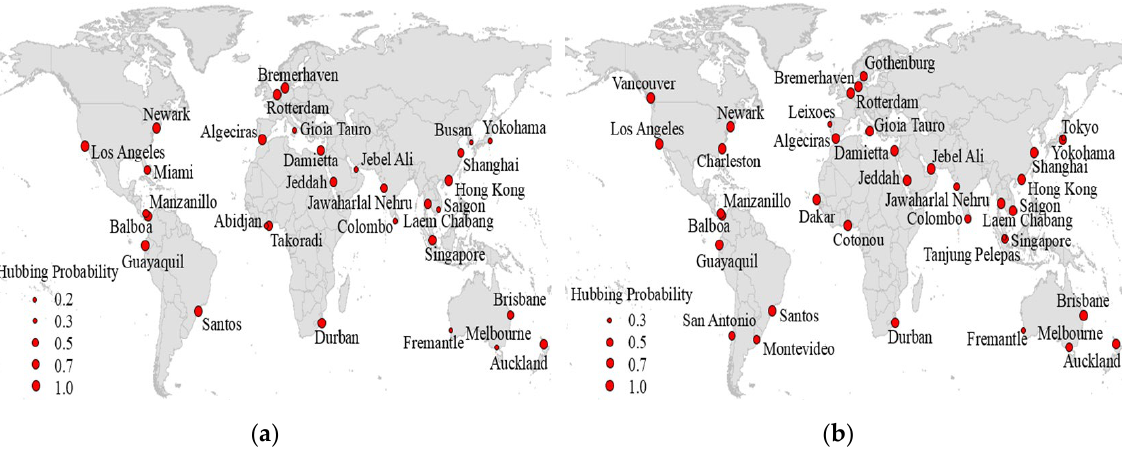
Figure 5. Hubbing probabilities for each port under multiple allocation schemes. ( a ) p = 2, ( b ) p = 3 .